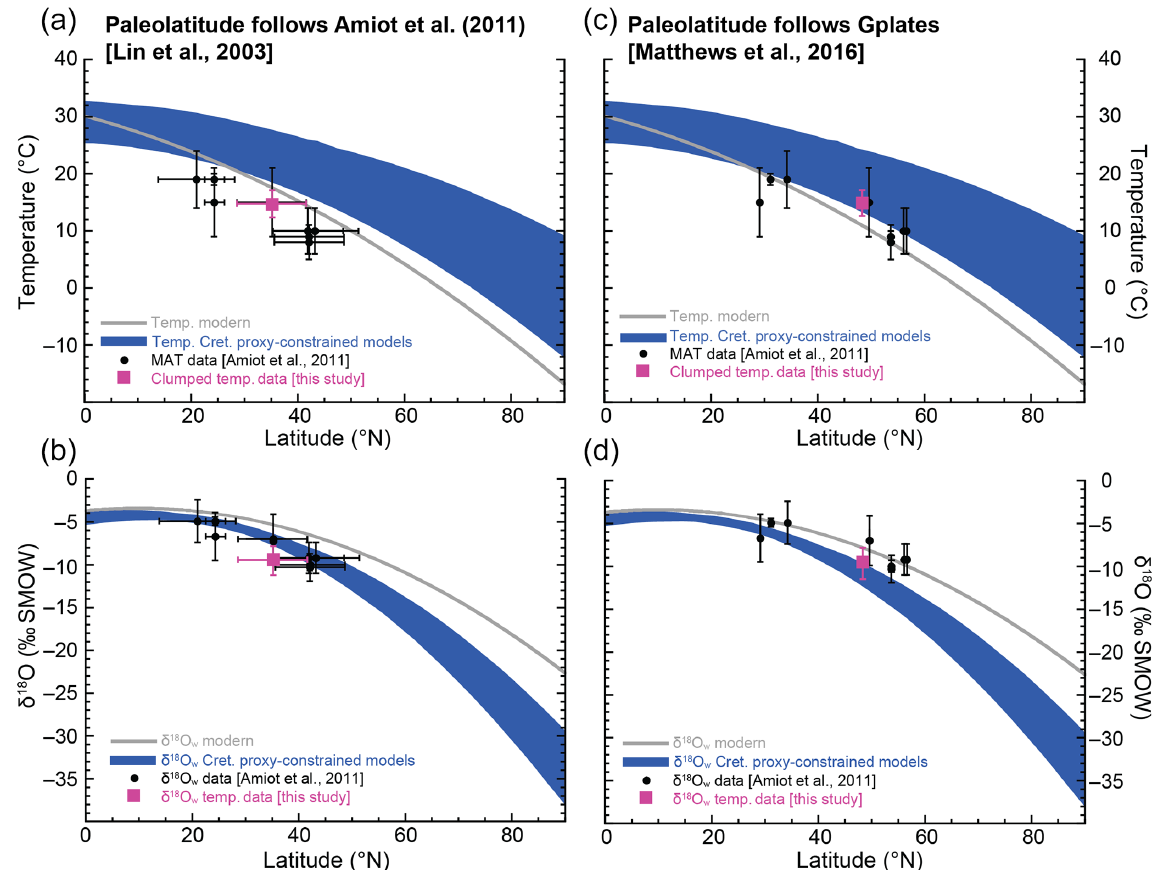
Figure 7. Northern Hemisphere latitudinal gradients of temperature and meteoric water δ 18 O for the mid-Cretaceous (Barremian–Albian). Our mean record data (pink) and the data of Amiot et al. (2011) (black) are plotted with a range in modeled gradients of Cretaceous climate as a function of latitude (blue shaded area) compiled in Suarez et al. (2011a). Details on models included in this range are in the main text. Modern temperature and meteoric water δ 18 O (gray lines) are plotted following Rozanski et al. (1993). The 1 σ uncertainty is included for all data. Two paleolatitude reconstructions are considered: Lin et al. (2003) (a, b) and Matthews et al. (2016) (c, d) . Uncertainty in latitude is included in panels (a) and (b) ; reconstructions of Matthews et al. (2016) do not provide